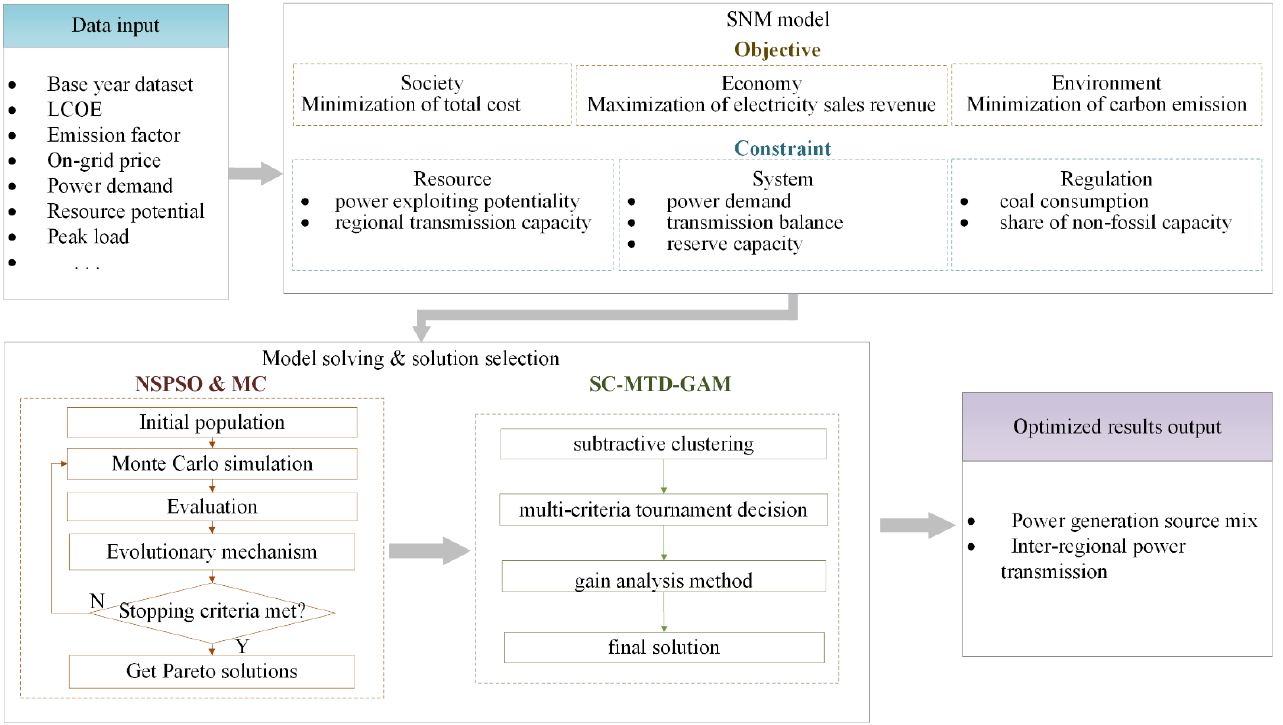
Figure 1. Proposed SNM Model